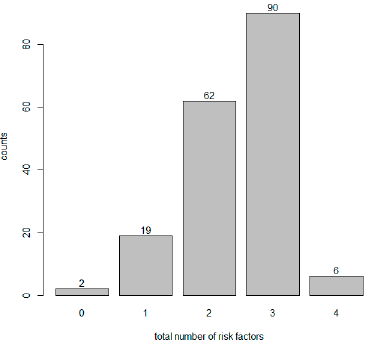
Figure 5. Patient distribution with respect to the total number of risk factors. Table 9. Association between PONV and total number of risk Table 6 . PONV risk factors associated with PONV.